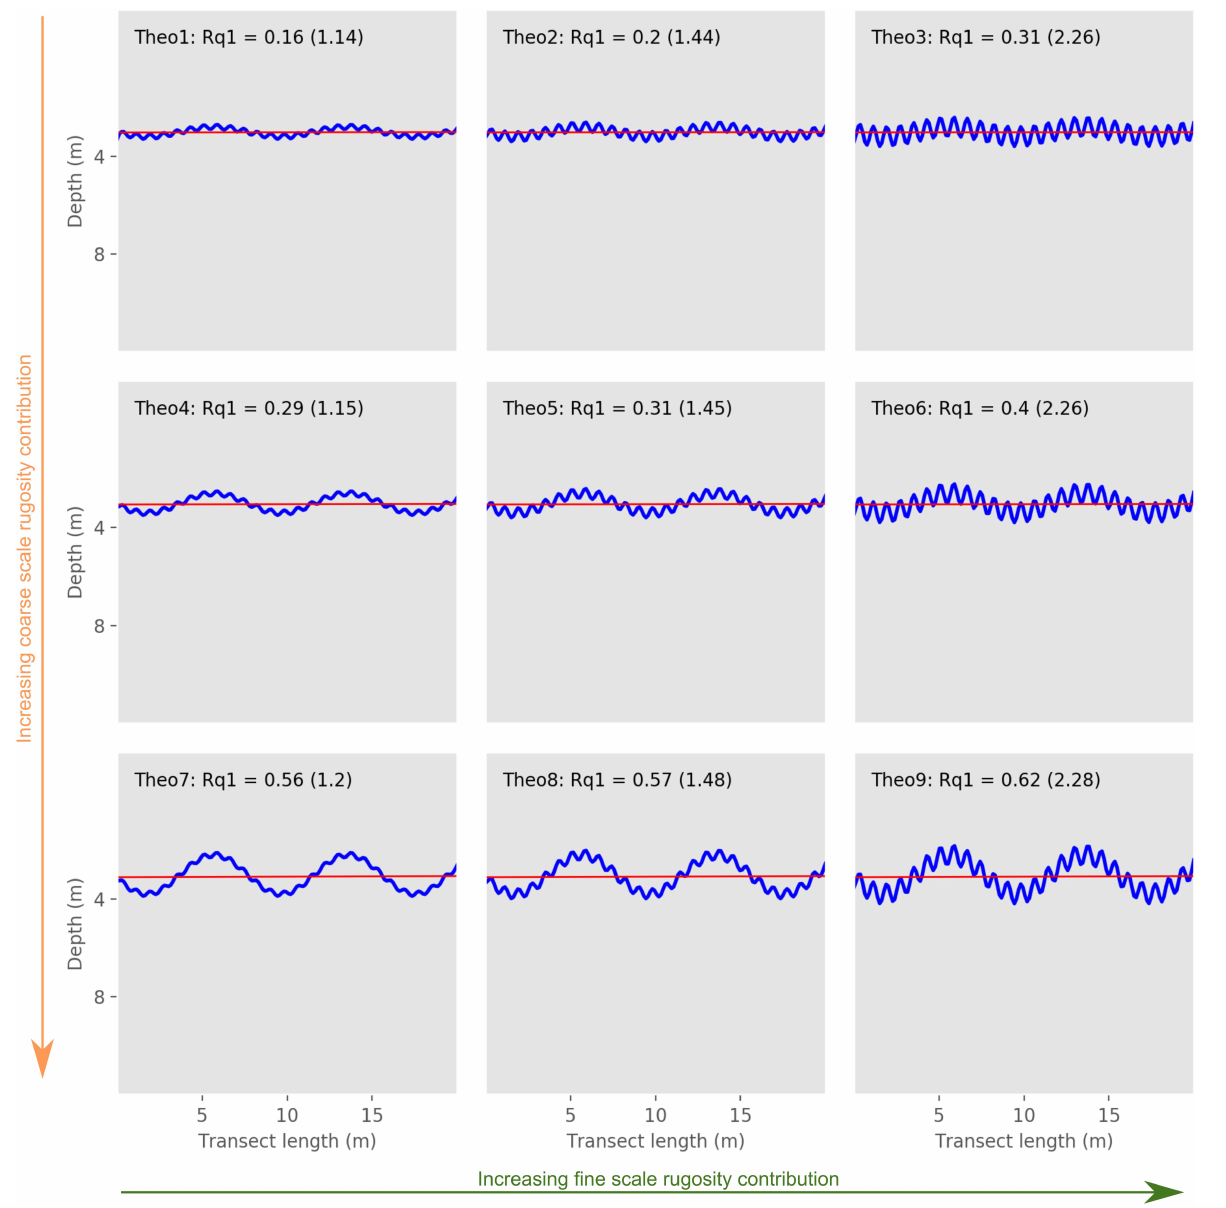
Their formula (Equation 3) resolves the inconsistency in the